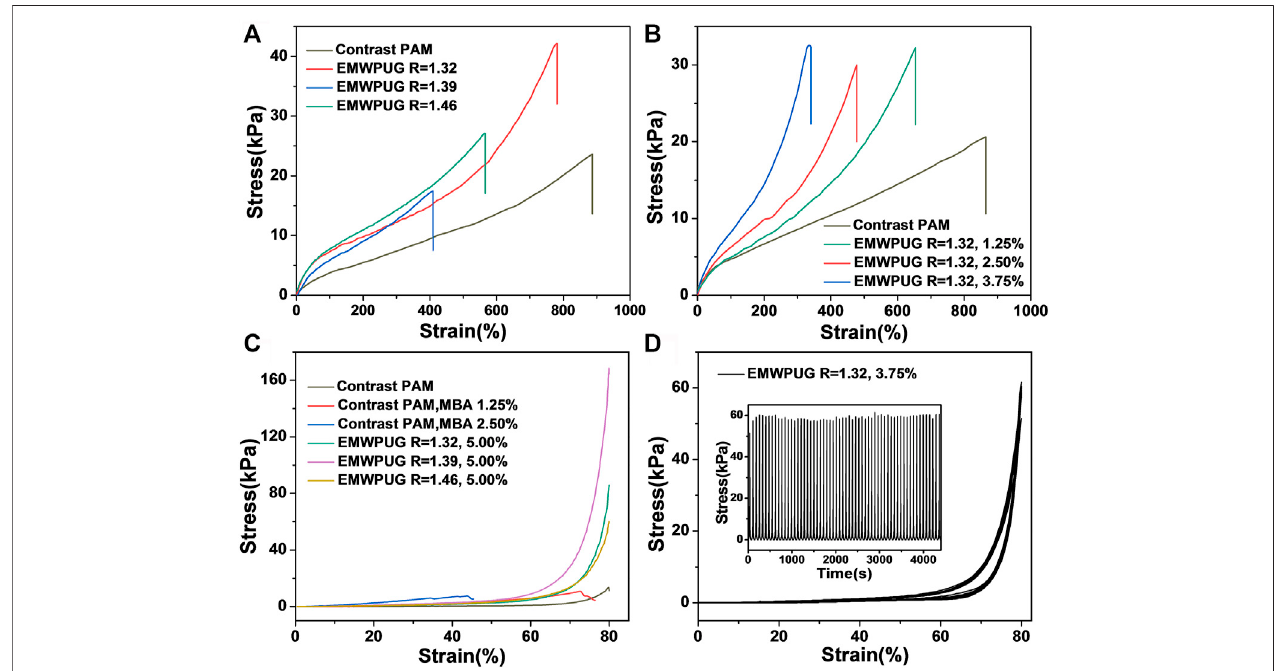
FIGURE 3 | Tensile strain – stress curves of the hydrogel at (A) various R values and (B) various mole percentages of the double bond of EMWPU R = 1.32. (C) Compressive strain – stress curves of the EMWPUG with mole percentage of EMWPU double bond at 5.00% and the contrast samples of different mole percentages of MBA. (D) Compression loading – unloading test (60 cycles) of the hydrogel